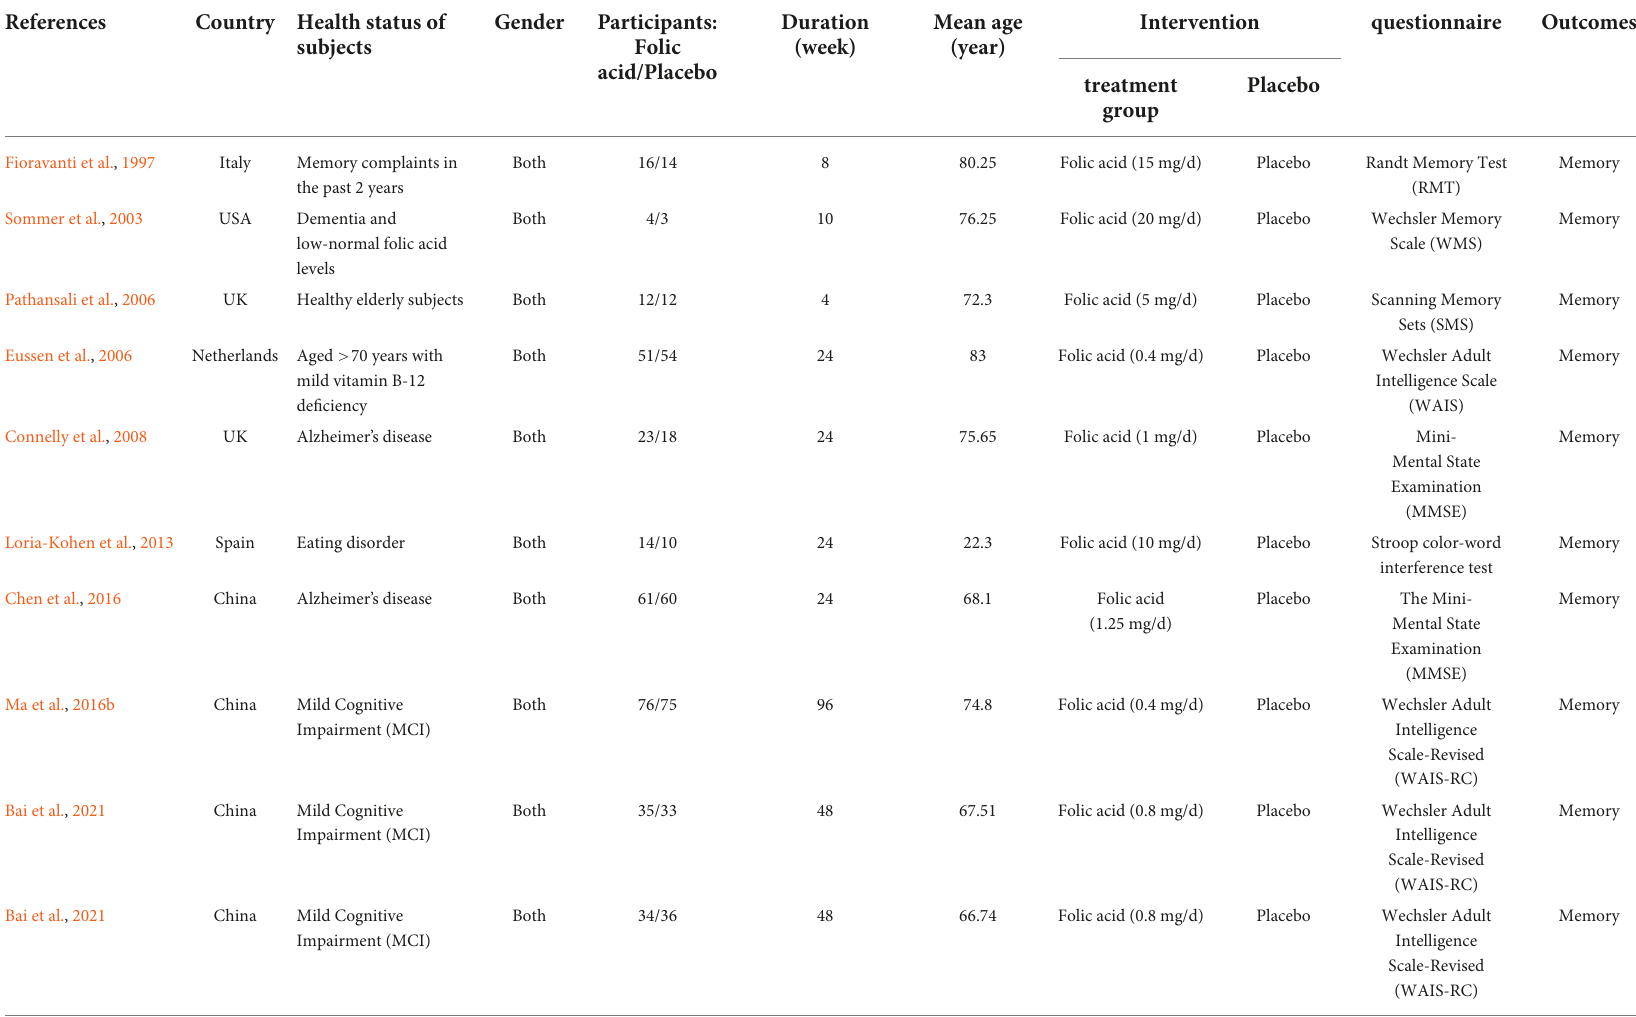
TABLE 2 General characteristics of randomized, double-blind, placebo-controlled parallel